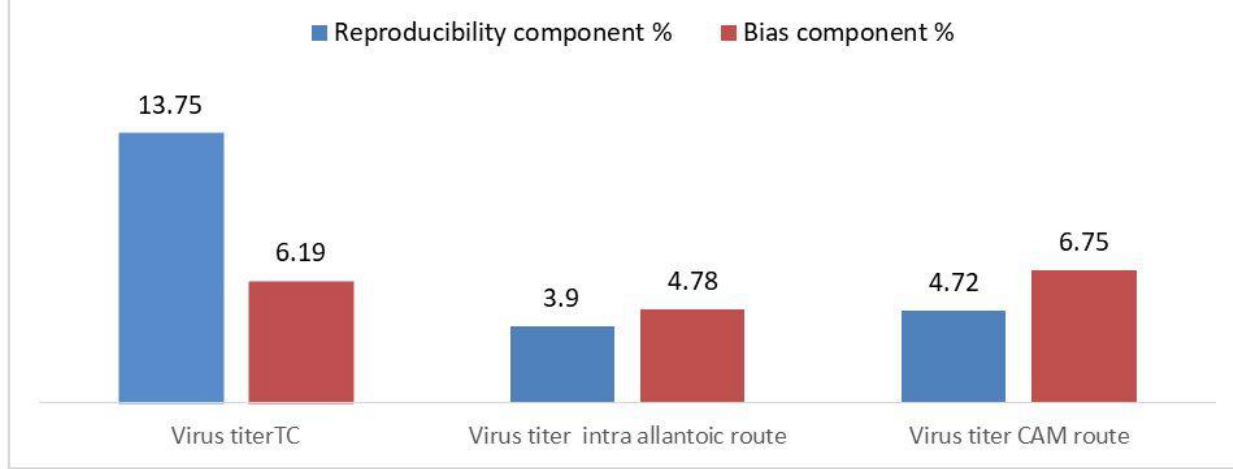
Fig. 11: Reproducibility and Bias component for virus titration by different technique.